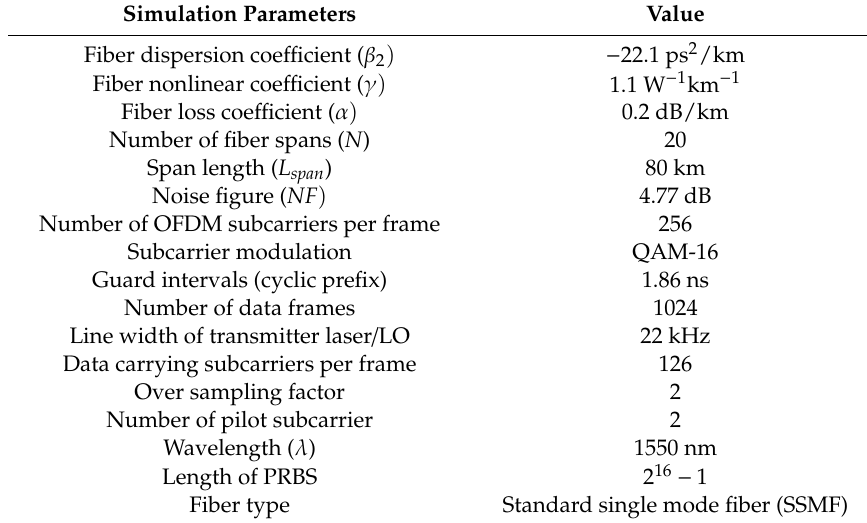
Table 1. The numerical simulation parameters of the orthogonal frequency-division multiplexing (OFDM)